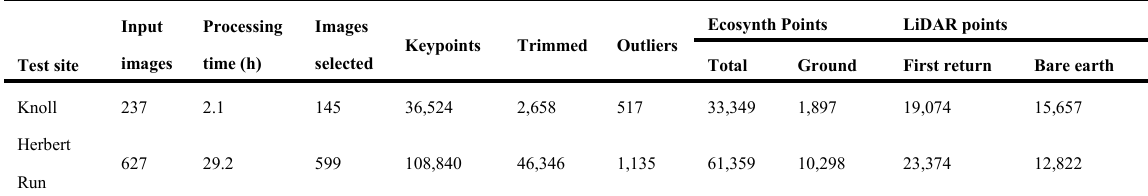
Table 1. Bundler points generated for Ecosynth compared with LiDAR across test sites (Figure